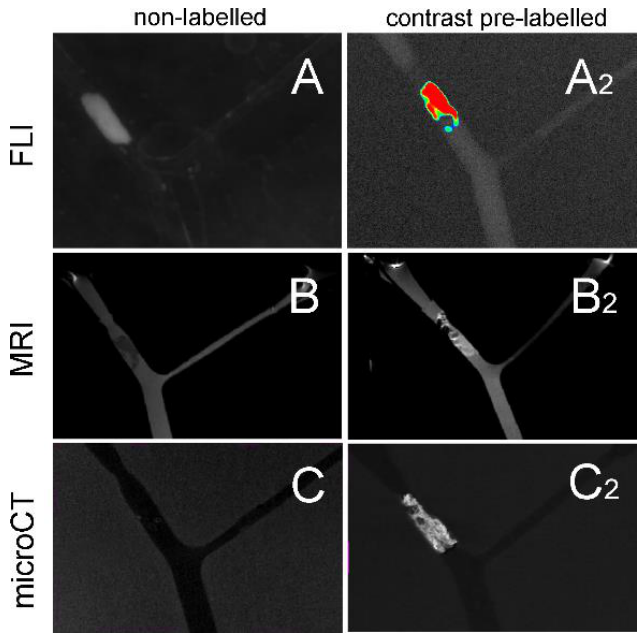
Figure 5. Imaging of pre-labelled clots in the MCA model using various preclinical imaging techniques. Multispectral fluorescent imaging ( A ), magnetic resonance imaging (MRI) ( B ), and microCT ( C ). Rhodamine-labelled, and gadolinium-labelled D7H2 liposomes targeted to fibrin were used for fluorescence imaging (FLI) and MRI, respectively. Non-targeted barium sulphate microparticles for microCT visualization were used as a contrast agent: negative controls ( A – C ), contrast pre-labelled clots ( A2 – C2 ). ( A )—the signal of scattered light. Each experiment was repeated three times, the figure shows representative pictures .